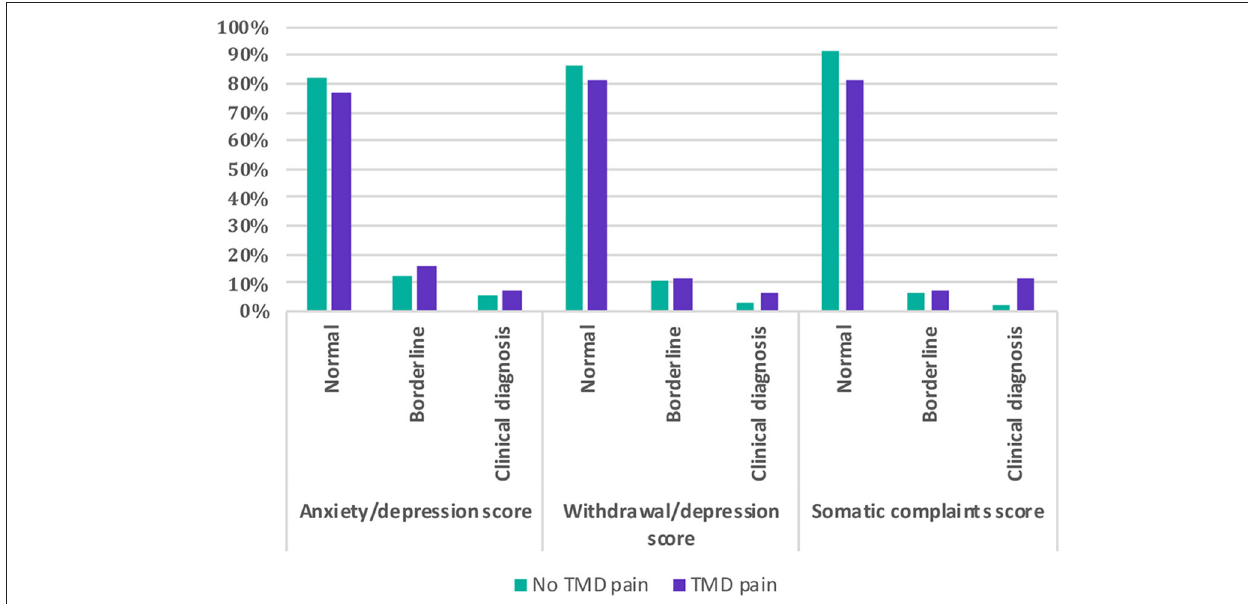
FIGURE 2 | Comparison of psychosocial scores (anxiety/depression, withdrawal/depression, and somatic complaints) among children and adolescents with and without self-reported painful temporomandibular disorders (TMD-P).